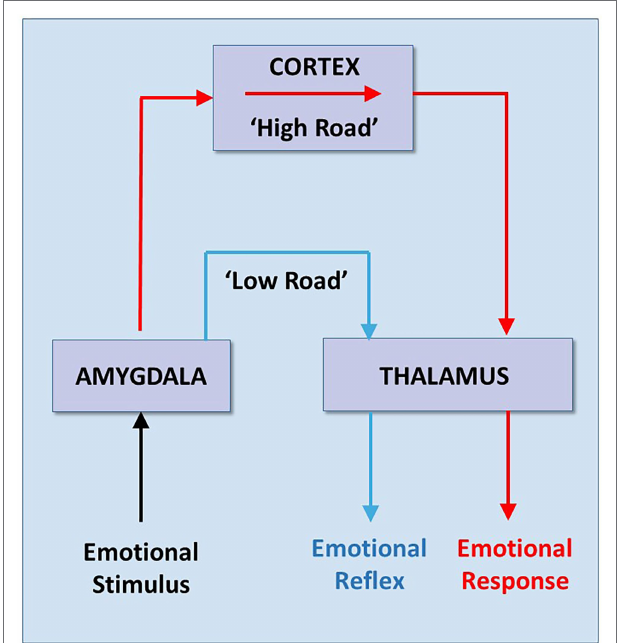
FIGURE 3 | Low and High Road reactions to Fear . Based on experiments in rats, Joseph LeDoux developed his theory that there are two signaling pathways that generate two different emotional reactions—a “lower” and faster but crude subcortical reaction (e.g., REFLEX), (blue line), and a “higher” and slower but more accurate cortical reaction (e.g., RESPONSE) (red line). Note that both reactions begin as an emotional “stimulus” from the body, but the stimulus pathway is not described. Adapted with permission from LeDoux